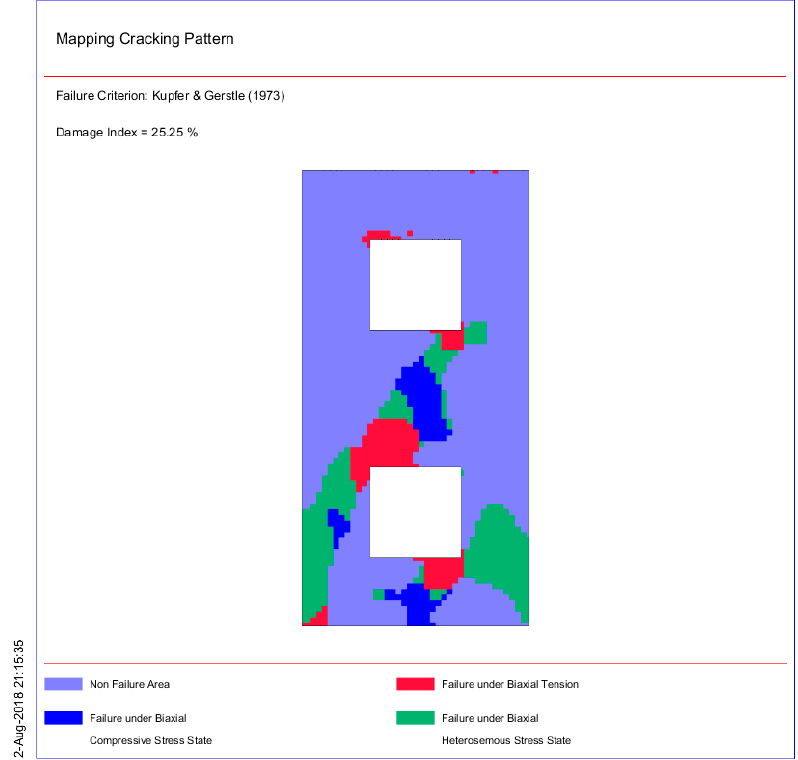
Figure 31. Mapping cracking pattern based on Kupfer and Gerstle’s (1973) failure criterion.